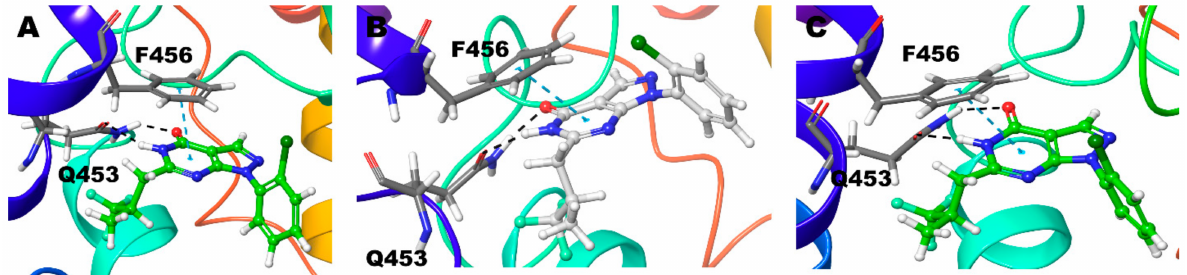
Figure 2. Non-bonded interactions of Compound 1 ( R ) in ( A ) PDE9 Zn/Mg ( B ) PDE9 Mg/Mg ( C ) PDE9 Zn/Zn.